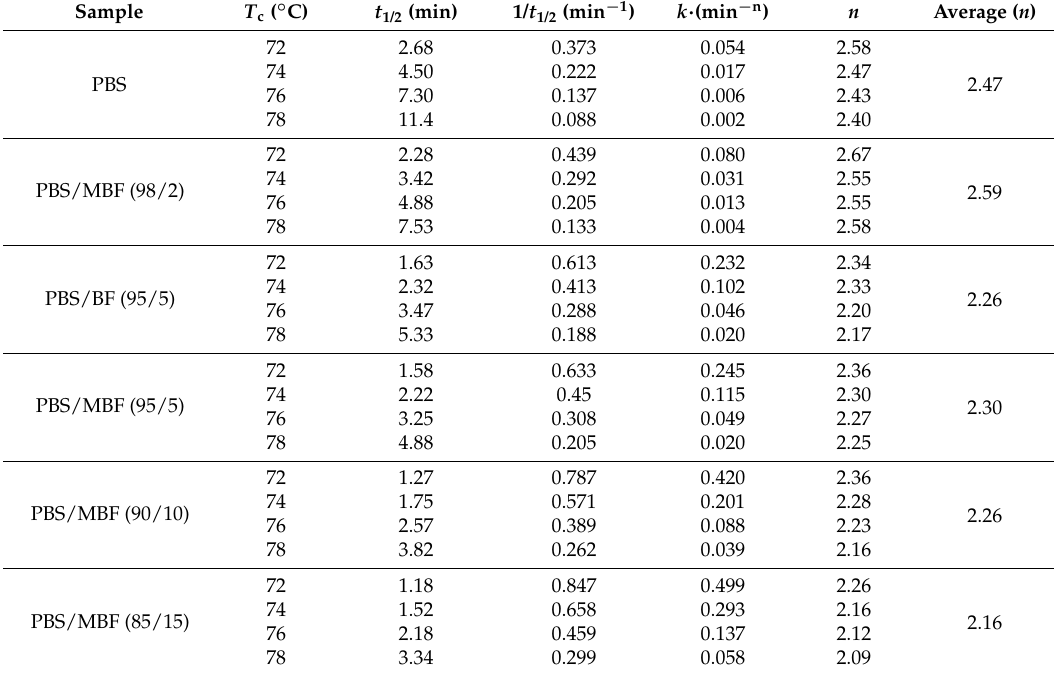
Table 1. Avrami parameters of isothermal crystallization kinetics of PBS, PBS/BF, and PBS/MBF.